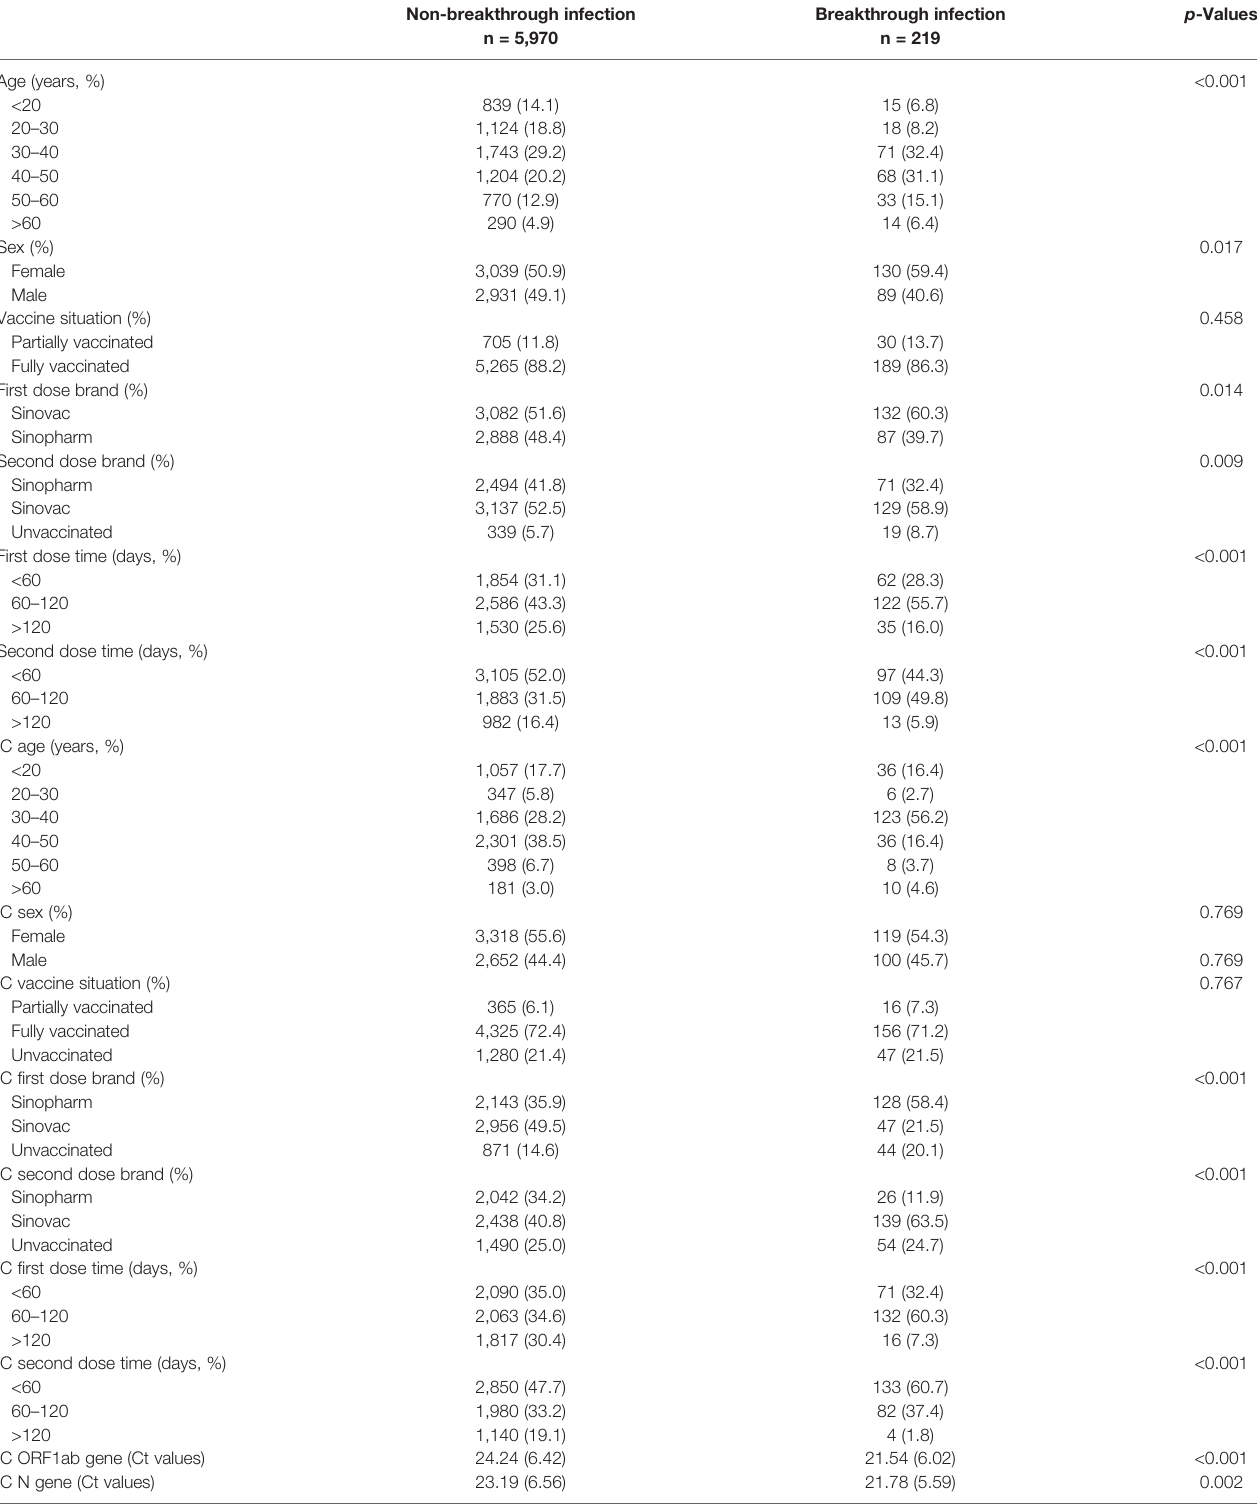
TABLE 1 | Characteristics of vaccinated individuals with or without SARS-CoV-2 breakthrough